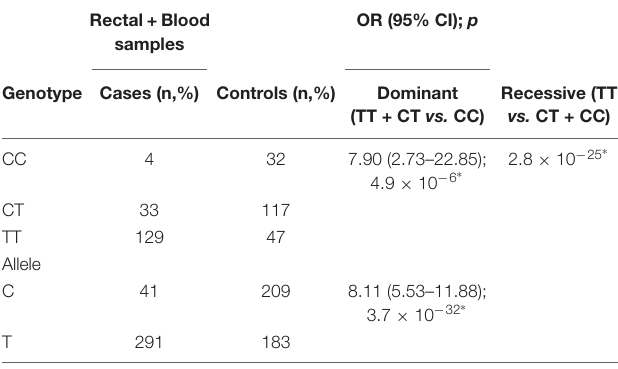
*Significance p < 0.05; CI, confidence interval; HSCR, Hirschsprung disease; OR, odds